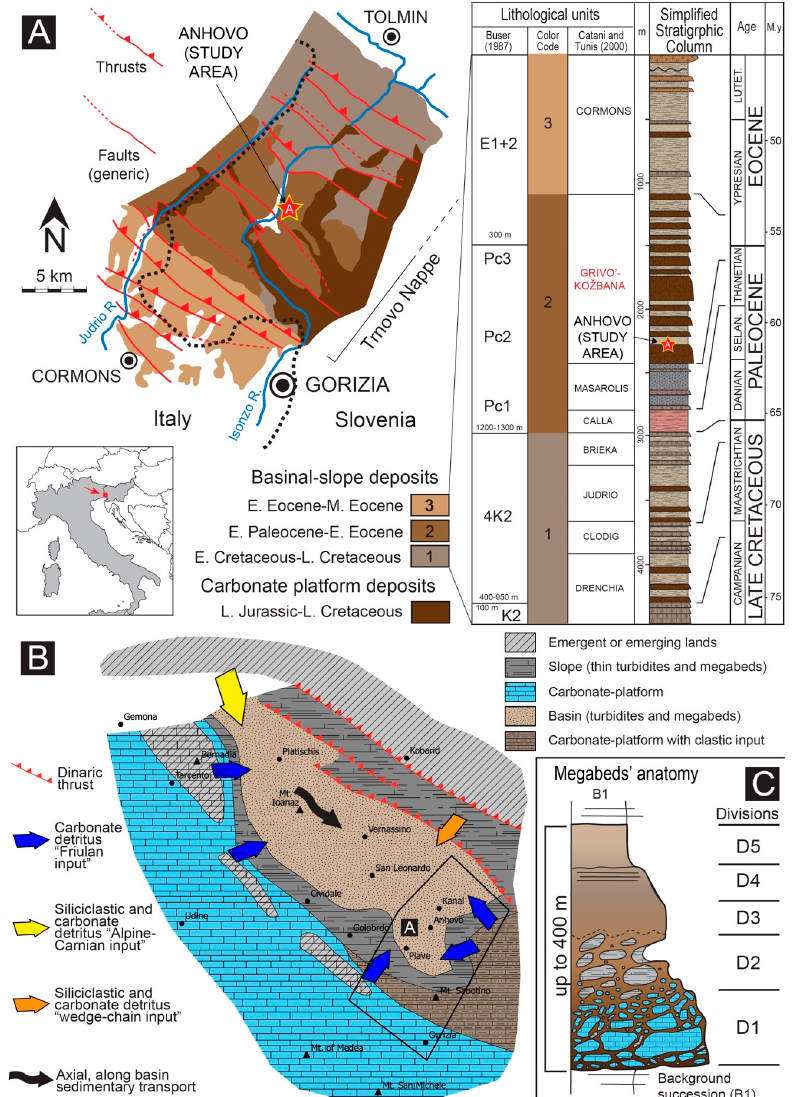
Figure 1. Geologic outline. ( A ). Simplified geologic map of the Julian Pre—Alps of the Eastern Friuli and Western Slovenia with schematic stratigraphic column of the upper Campanian–Paleogene clastic deposits of the Julian Basin (compiled from references [1,2,9,12]). Slovenian stratigraphic units: E1+2—Alternation of breccia, marlstone, claystone, siliciclastic carbonate and sandstone (Flysch), ca. 300 m thick; Pc3, Pc2, Pc1—Coarse- grained graded carbonate breccia with marlstone, and marly limestones, breccia interbeds, alternation of marlstones, mudstones and sandstones (Flysch), ca. 1200–1300 m thick; 4K2—Coarse-grained, graded carbonate breccia with marlstone, and marly limestones, breccia interbeds, alternation of marlstones, mudstones and sandstones (Flysch),